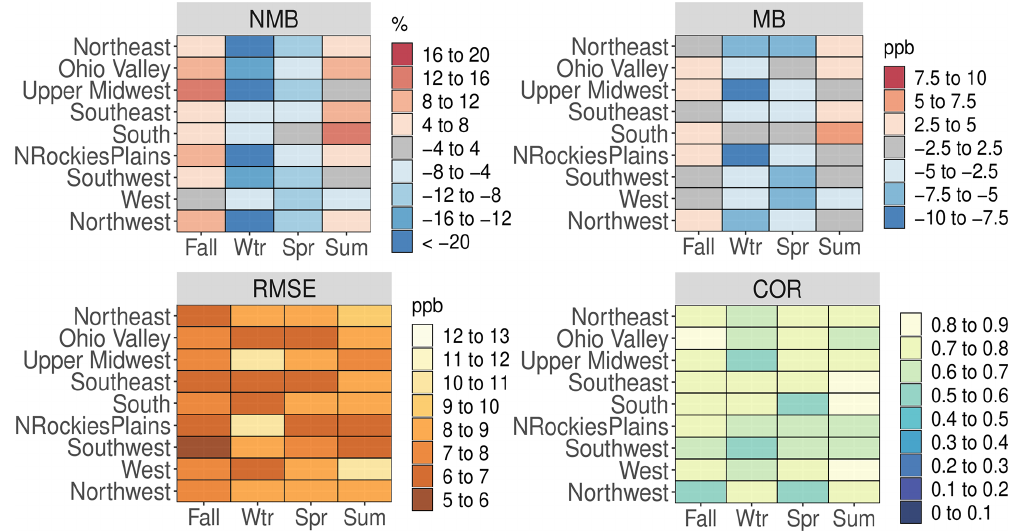
Figure 2. NMB (%), MB (ppbv), RMSE (ppbv), and Pearson correlation coefficient values for MDA8 O 3 for all AQS sites based on season and NOAA climate region for the CMAQ531_WRF411_M3Dry_BiDi